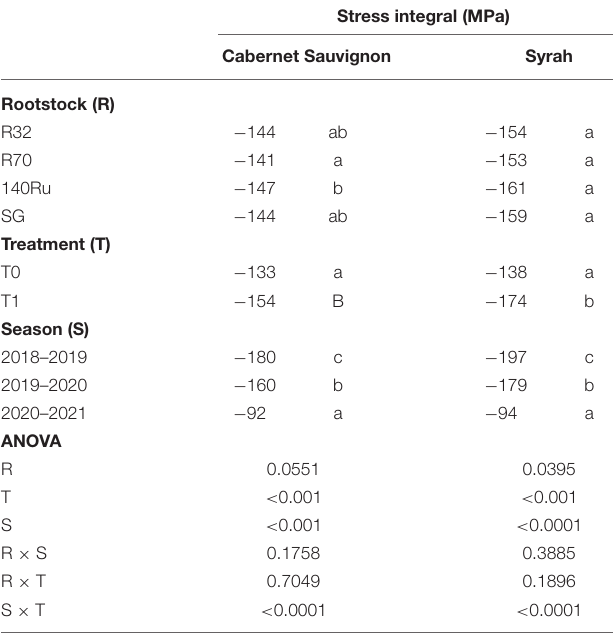
TABLE 2 | Effect of different rootstocks and irrigation treatments on mean seasonal values of water stress integral (SI 9 ). Stress integral